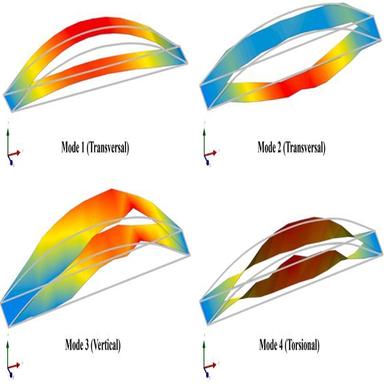
Vibration modes obtained from the OMA test.